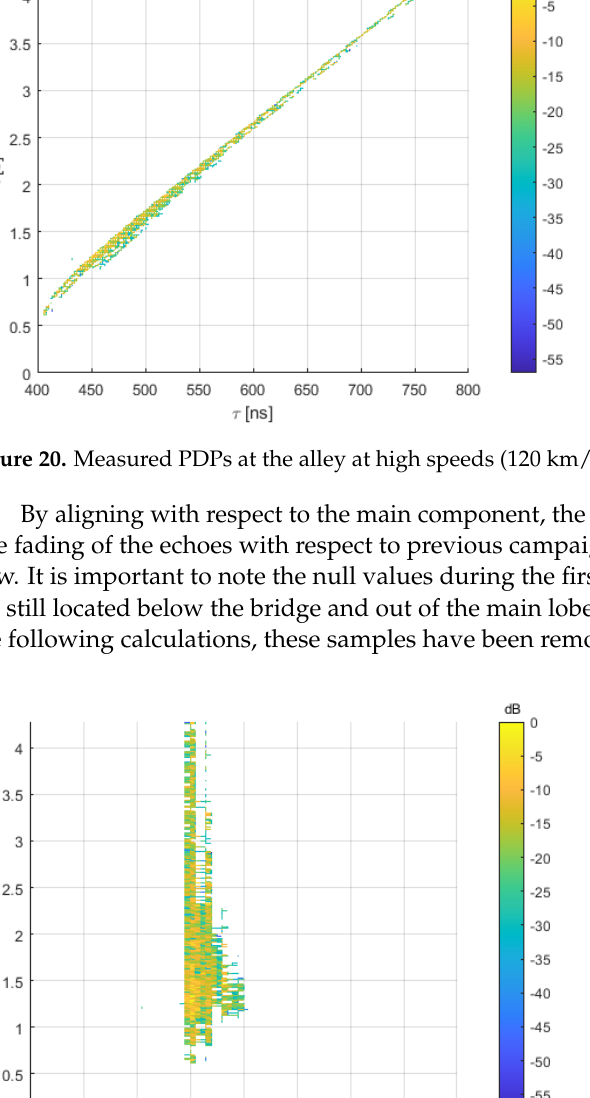
( b ) Figure 22. Delay spread in the highway: ( a ) variation along the measurement process; ( b ) CDF of the spread. The delay-Doppler spectra, both for the received data and the samples aligned to the main component, are shown in Figures 23 and 24. From the aligned responses, it can be derived that there is almost no multipath in the channel, which is consistent with what was previously exposed in this section. As we were moving away from the transmitter, it was expected that the main component would introduce a high Doppler shift in the neg- ative frequencies.